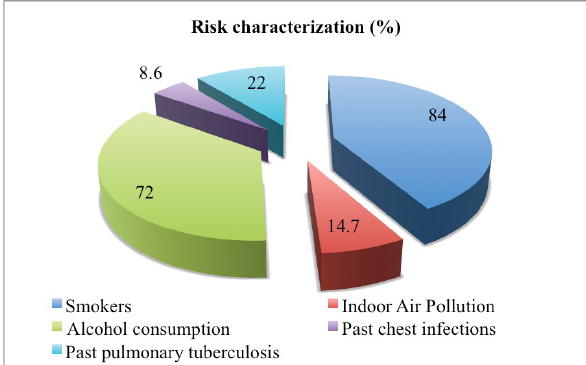
Figure 1: Risk characterization of patients presenting with symptom complex of respiratory diseases